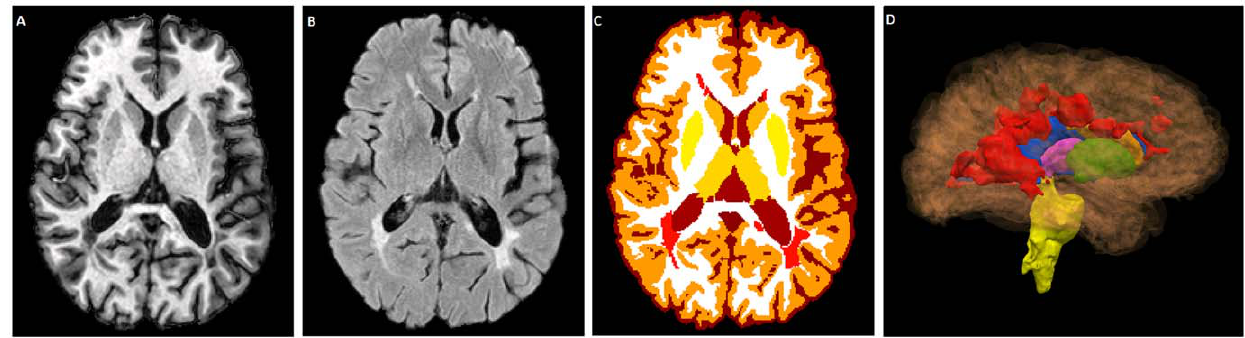
Figure 1. Lesion-TOADS segmentation results. Representative slices from the T1-weighted (A) and FLAIR (B) scans of one of the MS cases. Lesions are depicted in red (C). 3D rendering of ventricles (blue), putamen (green), caudate (orange), thalamus (pink), brainstem (yellow), and lesions (red), generated by Lesion-TOADS (D). doi:10.1371/journal.pone.0037049.g001 PLoS ONE |